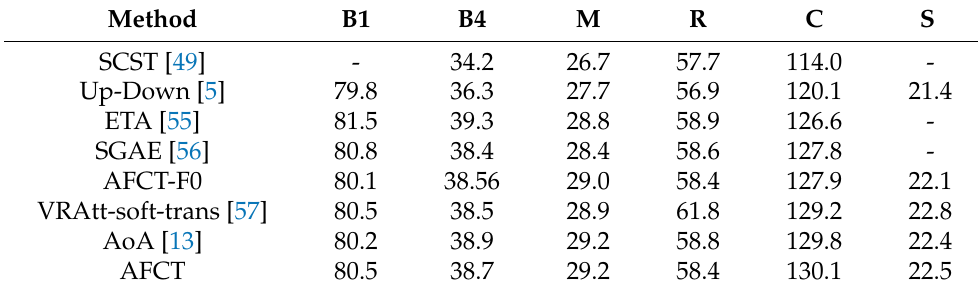
Table 1. Performance of comparison models on the Karpathy